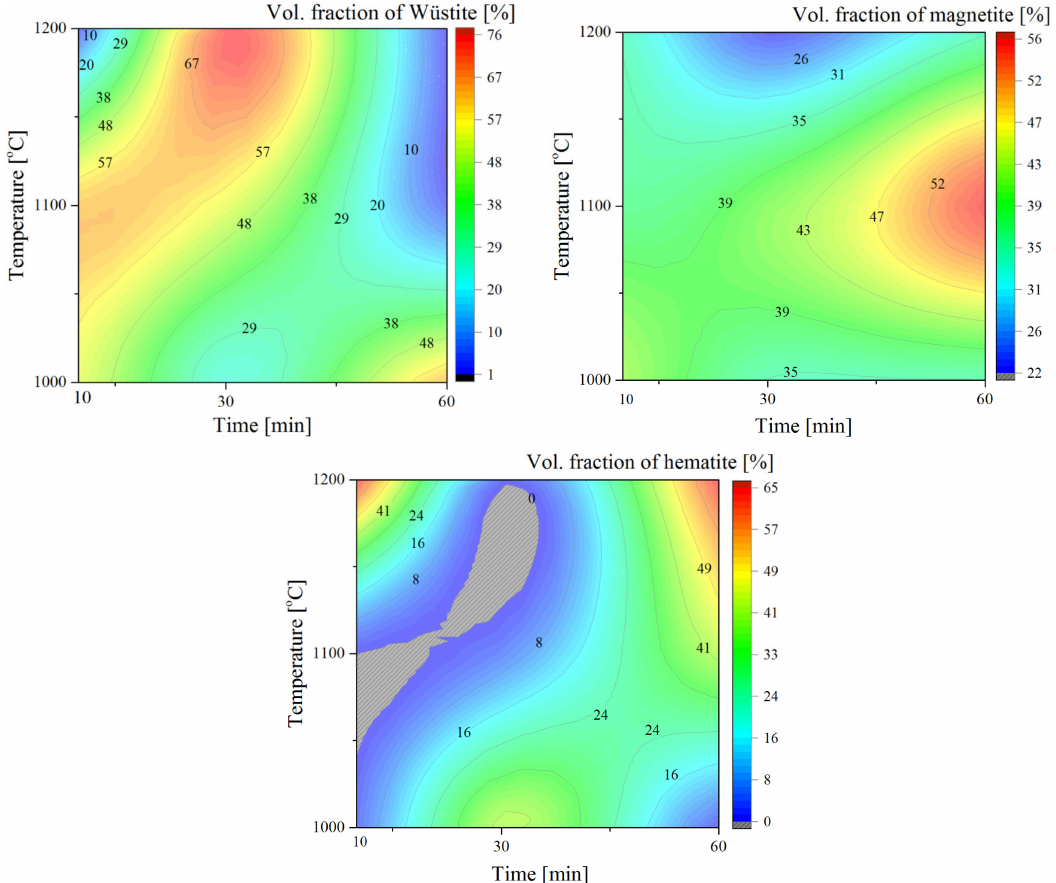
Figure 17. Color map plots showing the volume fraction of wüstite, magnetite, and hematite. The morphology of phases in oxide scales formed under water vapor are identified in Figure 18. It can be observed that wüstite (Fe 1 − x O), magnetite (Fe 3 O 4 ), and hematite (Fe 2 O 3 ) appeared with di ff erent colors due to the reaction from the di ff erent etchants applied to the oxide scale surface. For instance, wüstite appeared as the darkest phase at the steel / oxide interface. This phase predominated ◦ at 1200 C after 30 and 60 min of holding time; see an example in Figure 18d. Furthermore, magnetite formed at the top of the wüstite phase and appeared in either the light blue or brown color (Figure 18b,c). Magnetite appeared as the thickest oxide, being the predominant phase at 1100 holding time. A mixture of magnetite and hematite was commonly observed for all specimens with presence of small and big hematite grains (white / beige color) formed in a magnetite matrix (blue or dark brown color); see Figure 18a–c. Finally, hematite clearly appeared as the thinnest and lightest layer (white color) at the oxide / oxygen interface. Hematite is considered as a phase with a low metal content that mostly interacts with oxygen [19]; see Figure